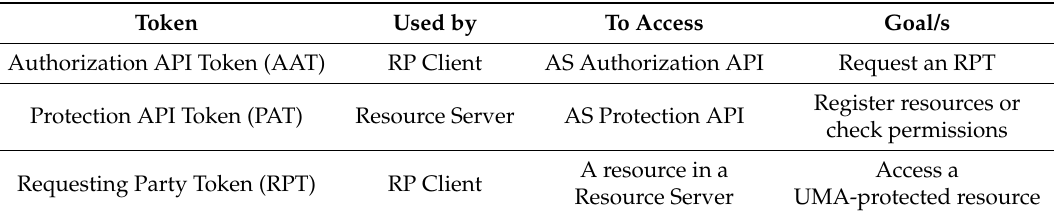
Table 1. Tokens used in User-Managed Access (UMA). API: Application Programming Interface; AS: Authorization Server; RP: Requesting